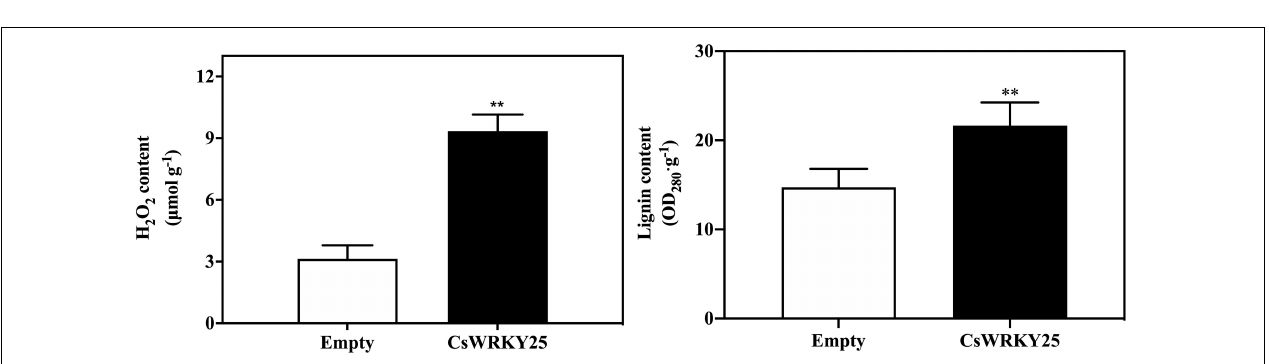
FIGURE 4 | Effects of transient overexpression of CsWRKY25 on resistance to P. digitatum in citrus fruit. (A) Diam of disease spot and incidence of disease affected by CsWRKY25 transient overexpression. (B) Phenotype of citrus fruit at 5 days after inoculation. (C) The relative expression levels of CsWRKY25, CsRbohB, CsRbohD, and CsPR10 . P values were regarded as statistically significant at * P < 0.05, ** P < 0.01.